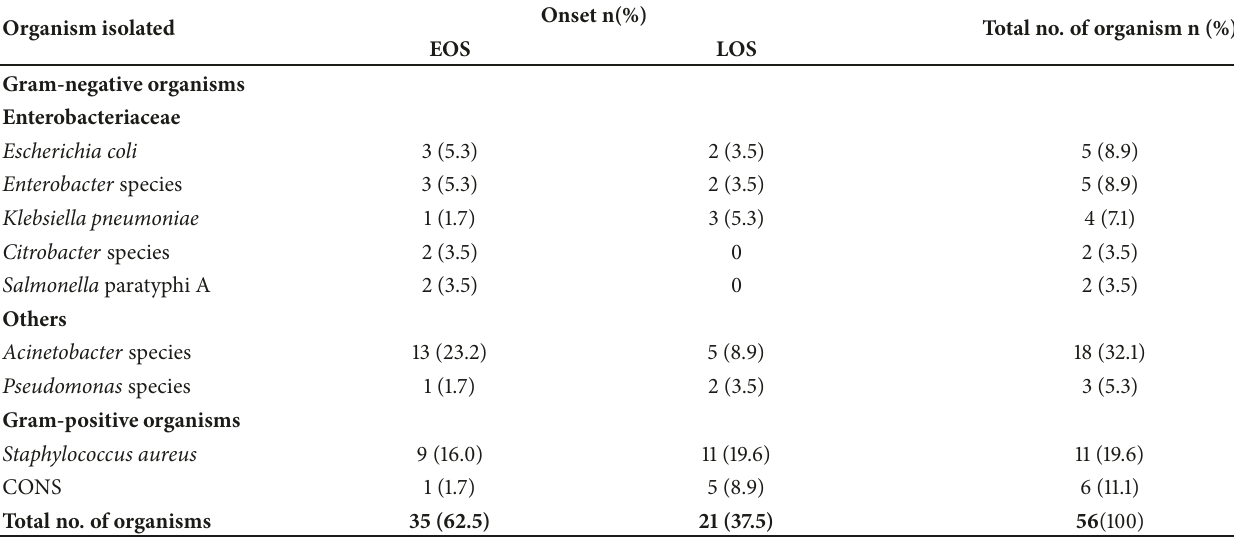
Table 2: Causative organisms of EOS and LOS.